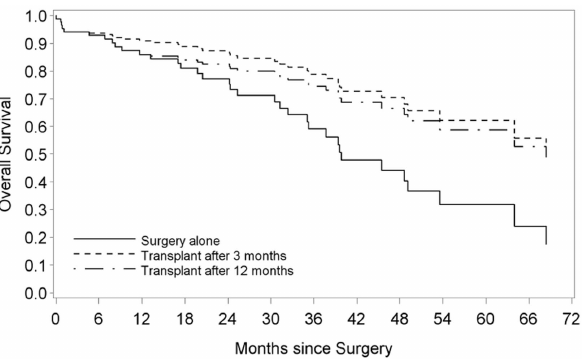
FIGURE 1 | Overall survival of cirrhotic patients with HCC after surgery and liver transplantation vs. surgery alone . Survival curves are obtained from a Cox regression with liver transplant as a time-dependent variable. The solid line represents patients without a liver transplant.The non-solid lines represent hypothetical samples of patients who receive a liver transplant after 3 and 12months, respectively.